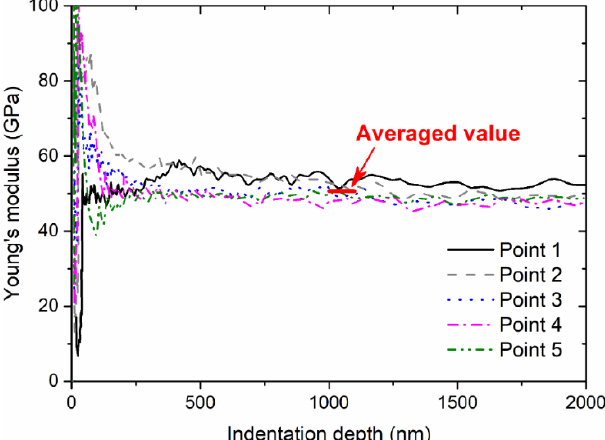
Figure 4. Measured value of Young’s modulus as a function of indentation depth.